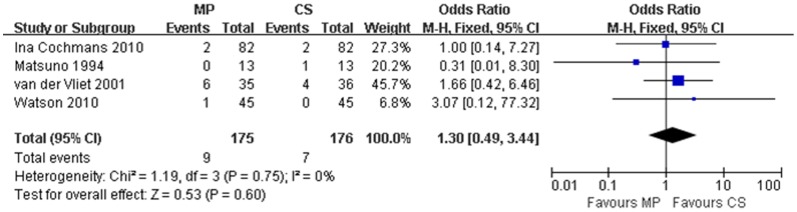
PNF rates for DCD kidneys preserved by MP versus CS.Pooled estimate of odds ratio (OR) and 95% confidence intervals (CIs) of PNF rates for DCD kidneys preserved by MP on 4 studies. Squares indicate OR in each study. The square size is proportional to the weight of the corresponding study; the length of horizontal lines represents the 95% CI. The rhombus indicates the pooled OR and 95% CI (fixed-effect model).